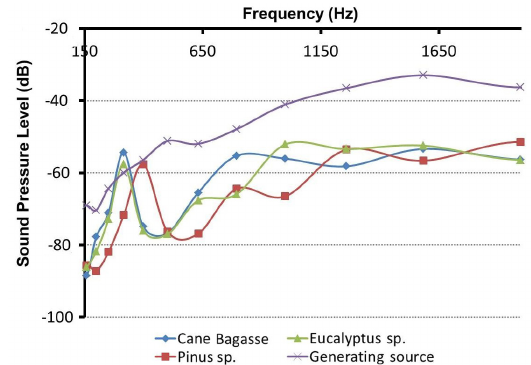
Figure 6. Levels of sound pressure between frequencies of 100 Hz to 2,000